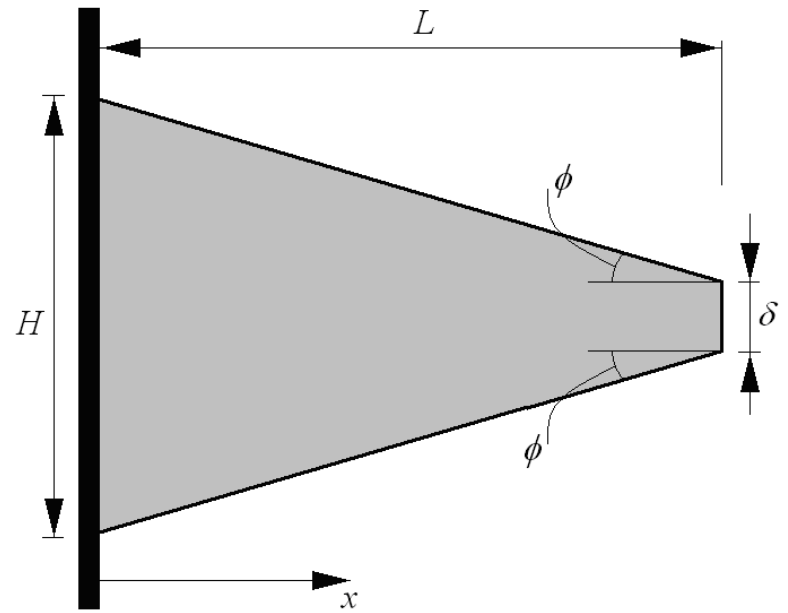
Figure 3. Lateral view of a longitudinal trapezoidal fin with width W .